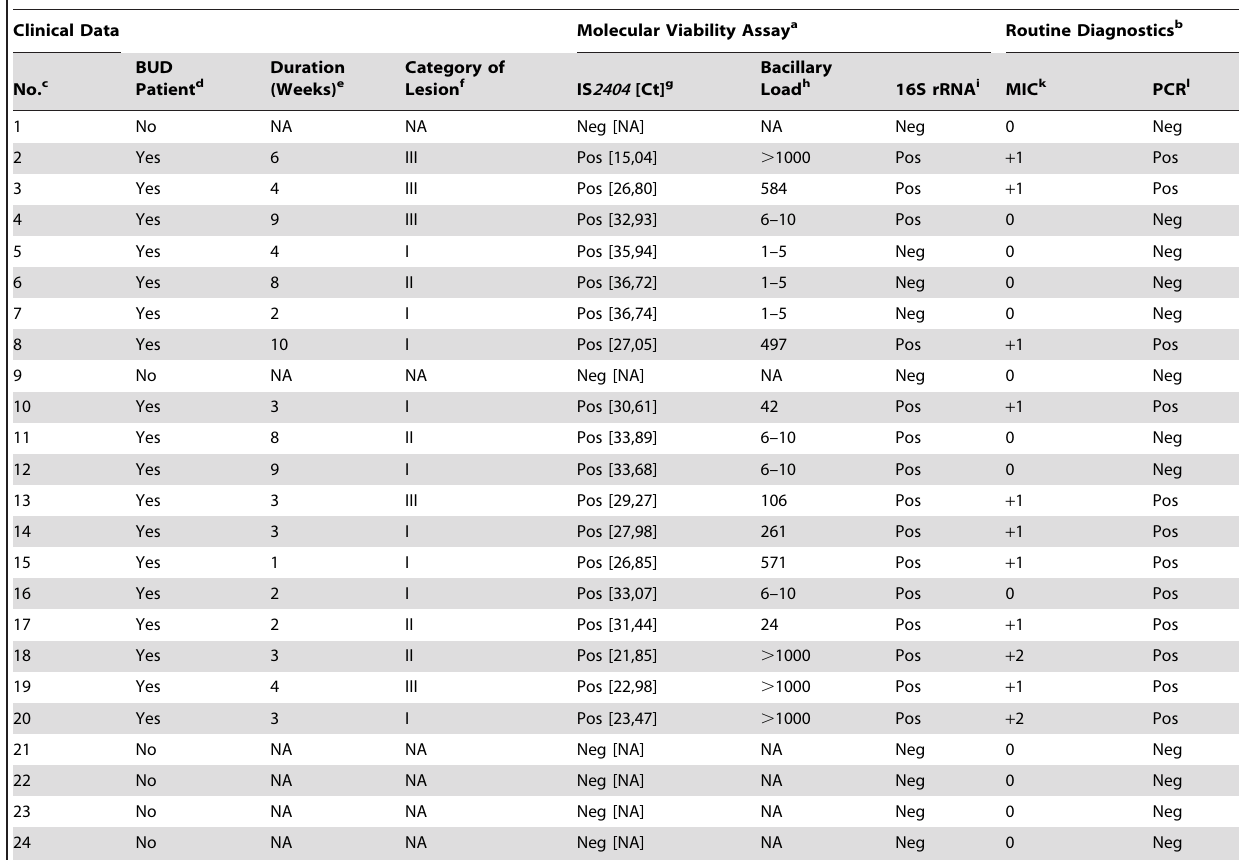
Table 6. Study participants, clinical information, and diagnostic